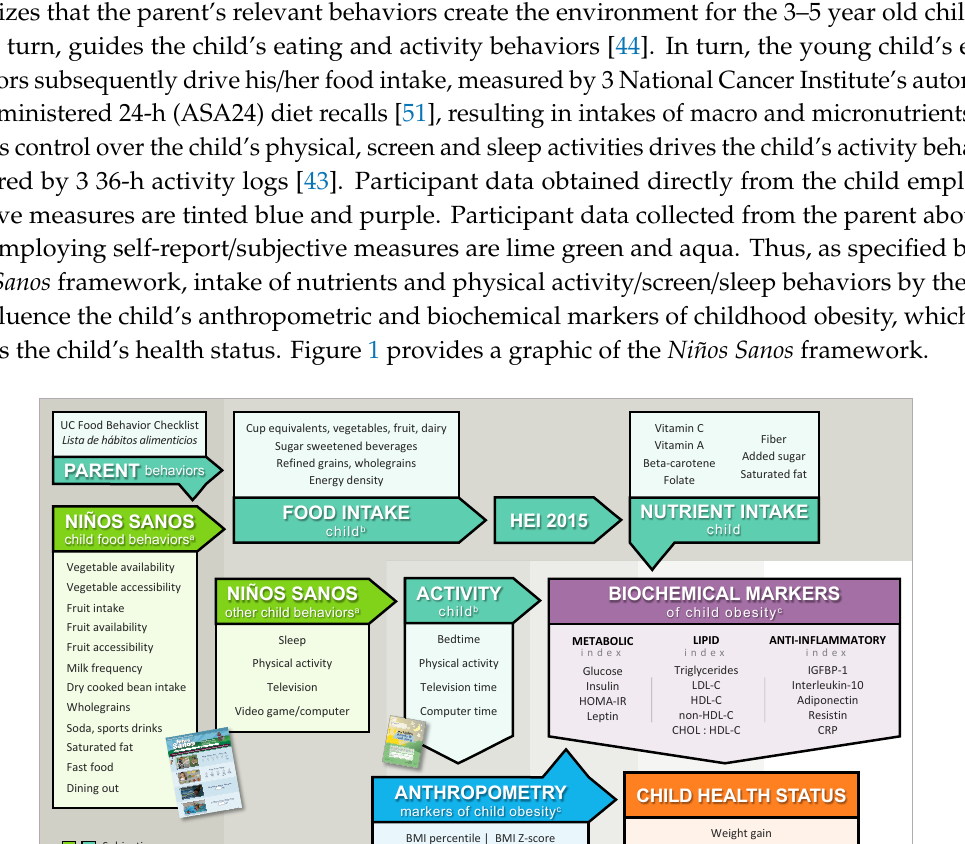
Figure 1. Biopsychosocial framework for validation of Niños Sanos targeting immigrant families with preschool-aged children. a Child dietary, physical activity, sleep and screen behaviors collected with original pool of 45-items for Niños Sanos . b Child diet estimated with 3 University of California Child Eating and Activity Diary and the National Cancer Institute’s Automated Self-Administered 24-h (ASA24) diet recalls. Child physical, screen, and sleep activities were estimated with 3 36-h activity logs using same Diary. c Child height, weight, waist, blood, blood pressure and body temperature were collected. Abbreviations: HEI: healthy eating index; ASA24: automated self-administered 24-h dietary assessment tool; HOMA-IR, homeostatic model assessment of insulin resistance; LDL-C, low density lipoprotein cholesterol; HDL-C, high density lipoprotein cholesterol; non-HDL-C, non-high density lipoprotein cholesterol; CHOL:HDL-C, cholesterol to high density lipoprotein cholesterol ratio; IGFBP-1, insulin-like growth factor binding protein-1; IL10, interleukin 10; CRP, C-reactive